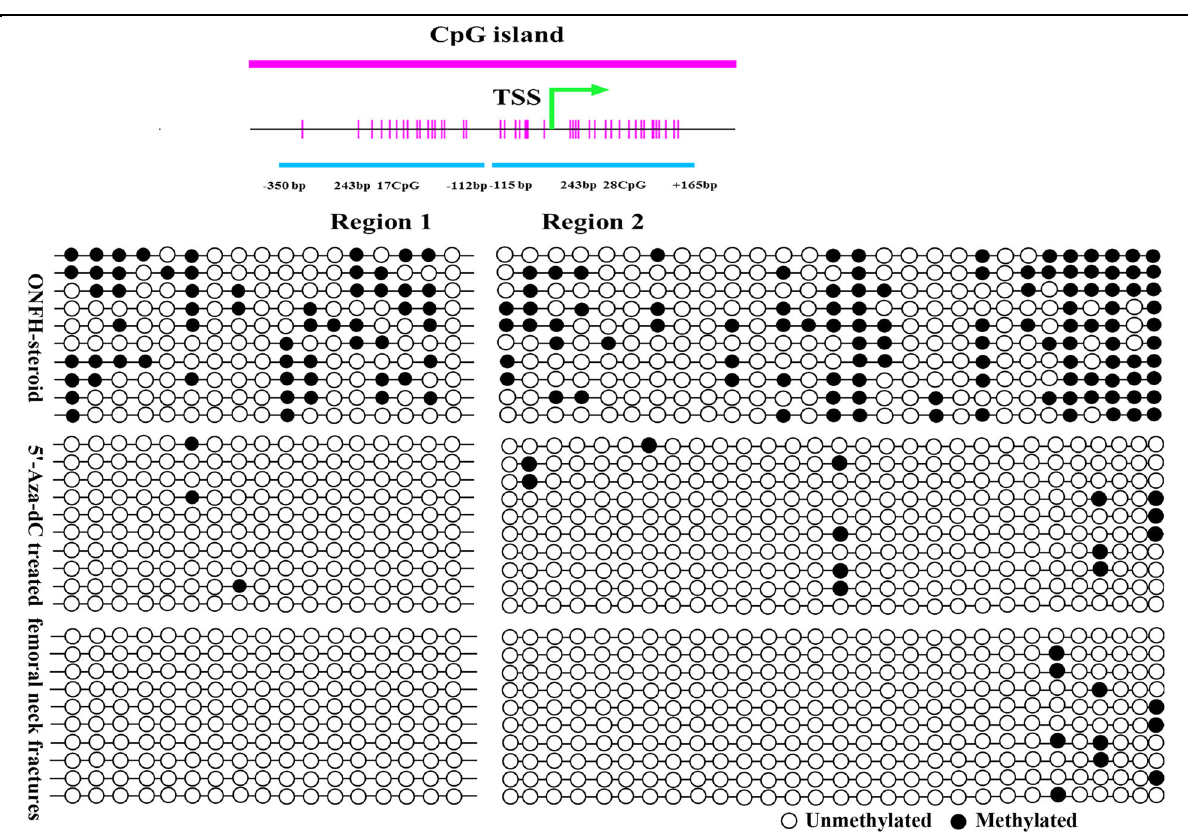
Fig. 6 Bisul fi te sequencing. Region 1 ( − 350 to − 112 bp): The methylation ratios were 33.0% in the ONFH group, 1.8% in the 5 ’ -Aza-dC group and 0 in the control group. Region 2 ( − 115 to + 165 bp): The methylation ratios were 38.6% in the ONFH group, 4.6% in the 5 ’ -Aza-dC group and 3.6% in the control